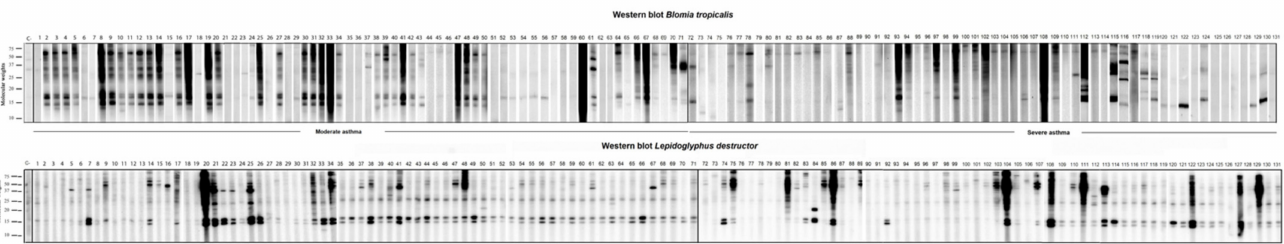
Figure 3. Sensitization profile to specific IgE (sIgE) ( A ) and heatmap ( B ) to a comprehensive panel of molecular allergens of Dermatophagoides pteronyssinus, Blomia tropicalis, Lepidoglyphus destructor, Glyciphagus domesticus and Tyrophagus putrescentiae in 133 moderate (m) to severe (s) asthmatic patients. Broadly different patterns of sIgE were identified in both groups of asthmatics.